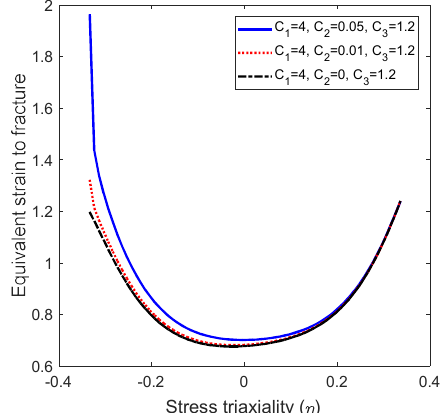
Figure 2. Fracture locus for high-strength steel 690.